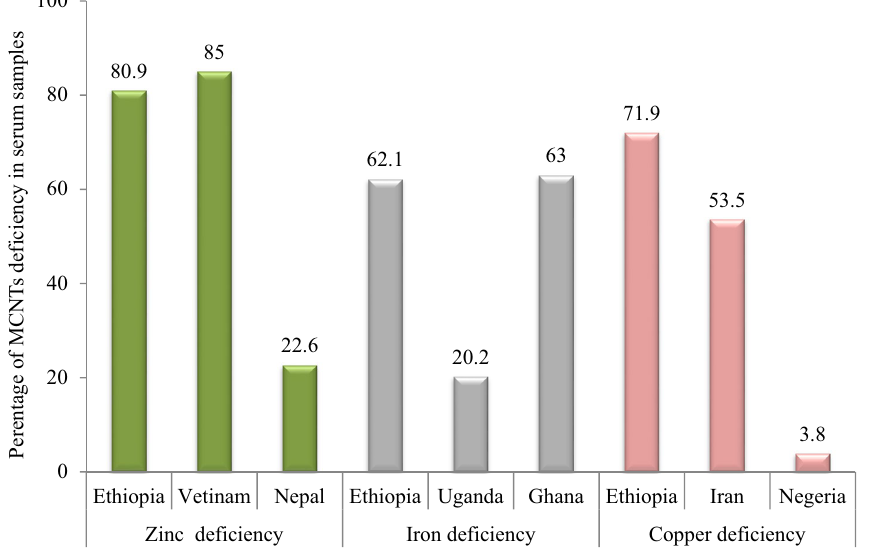
Figure 2. Prevalence of zinc, iron, and copper deficiency level (μgdL −1 ) of pregnant women in different